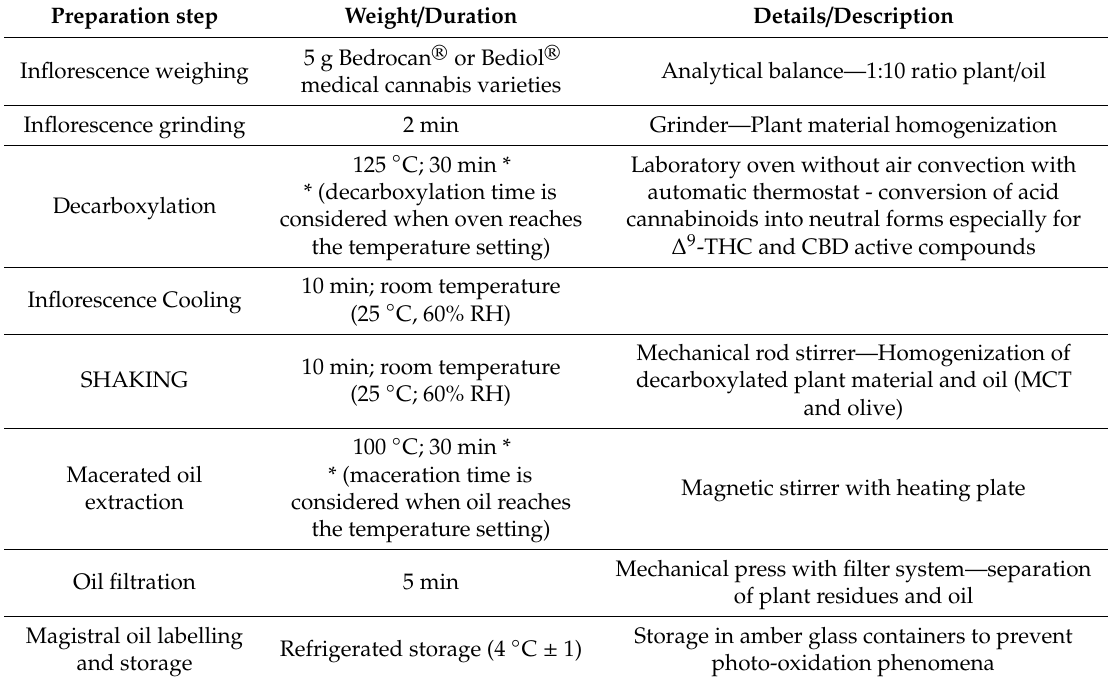
Table 4. Cannabis oil preparation parameters adopted in the present